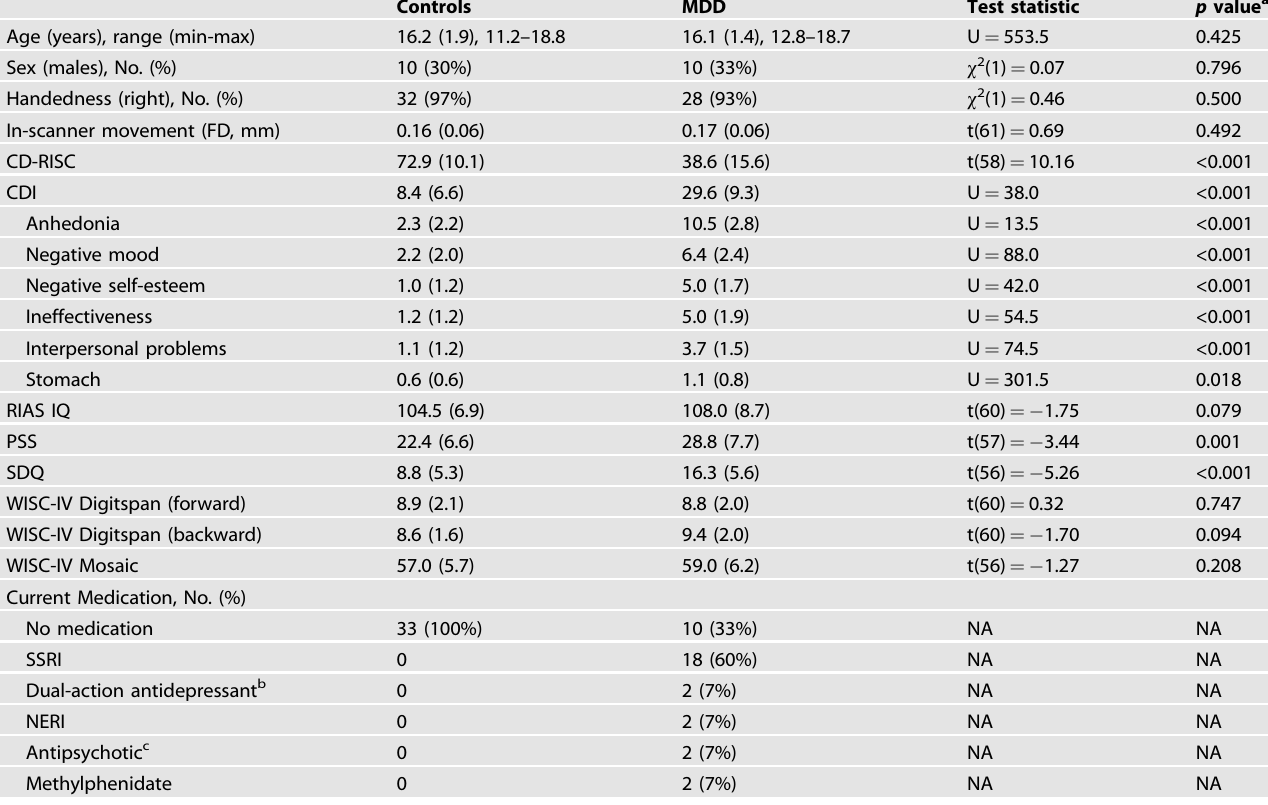
Table 1. Clinical and demographic characteristics of study